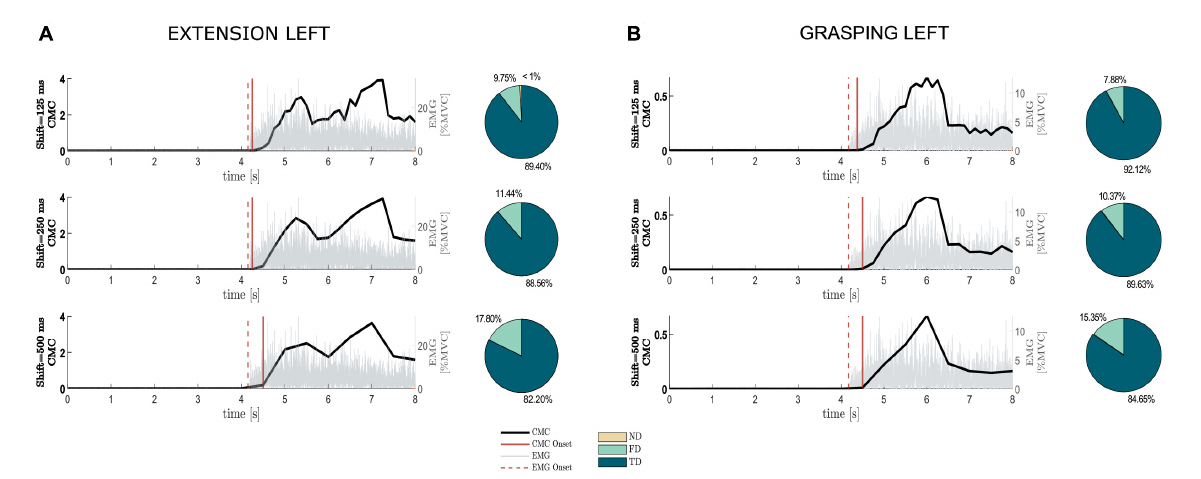
FIGURE2 Impact of the shift value used in the sliding-window approach on the detection of the movement onset based on CMC (CMC onset). The average CMC and EMG trends across trials, considering the first EEG-EMG pair identified by Fisher criterion and the target muscle, respectively, were reported along trial duration for different shift values separately for extension and grasping of the left hand, ( A,B , right panel), respectively, in one representative healthy participant (similar results were obtained for right-hand movements). Dashed vertical line represents movement onset detected from EMG (EMG onset), whereas continuous vertical line stays for detected CMC onset. Each graph is flanked by a pie chart reporting the percentages of No Detection (ND), False Detection (FD) and True Detection (TD) obtained on average across 13 healthy participants for the different shift values in the two motor tasks